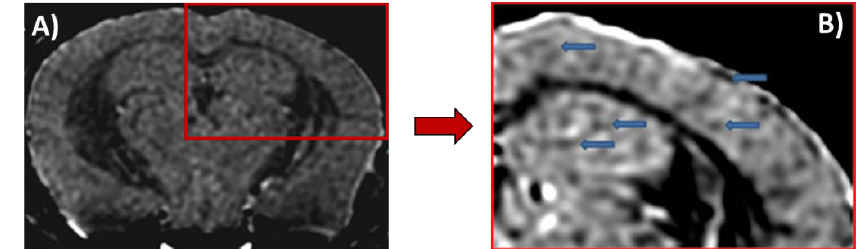
Figure 3. T2*-weighted image of 14-month old APP/PS1 transgenic mice after intravenous femoral injection of IONPs conjugated with PEG and A β 1-42. ( A ) Coronal slice of whole brain at 7T MRI with 100 µm isotropic resolution, with highlighted region, including the cortex and the hippocampus, shown with higher magnification in ( B ). Arrowheads mark some of the hypointense regions indicative of IONP-PEG-A β 1-42 localization corroborated with immunolabeling studies. Images from Wadhgiri et al. [11] .